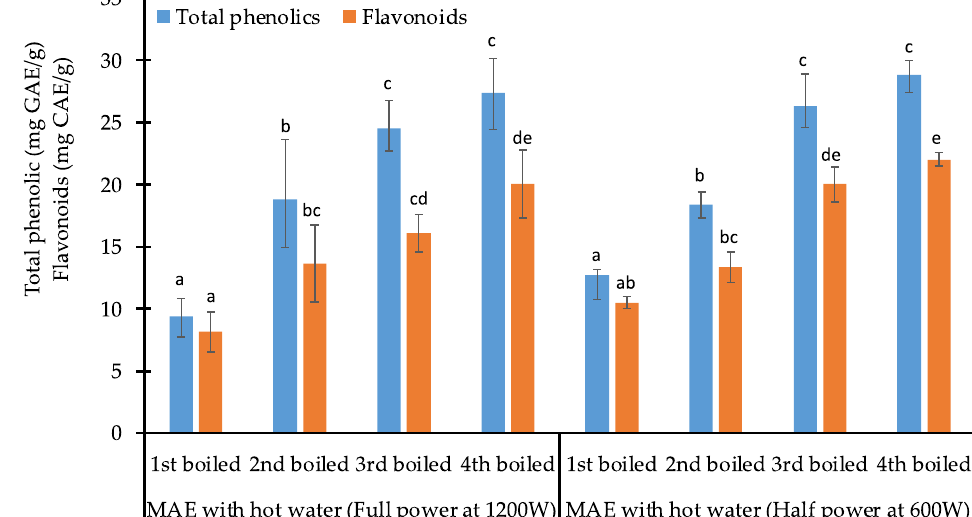
Figure 4. Extractability of total phenolic content (TPC) and total flavonoids (TFC) of herbal tea infusion prepared at different microwave assisted conditions with hot water. Data are means ± standards deviations. Data for each phytochemical group (TPC or TFC) not sharing similar letters are significantly different at p < 0.05.